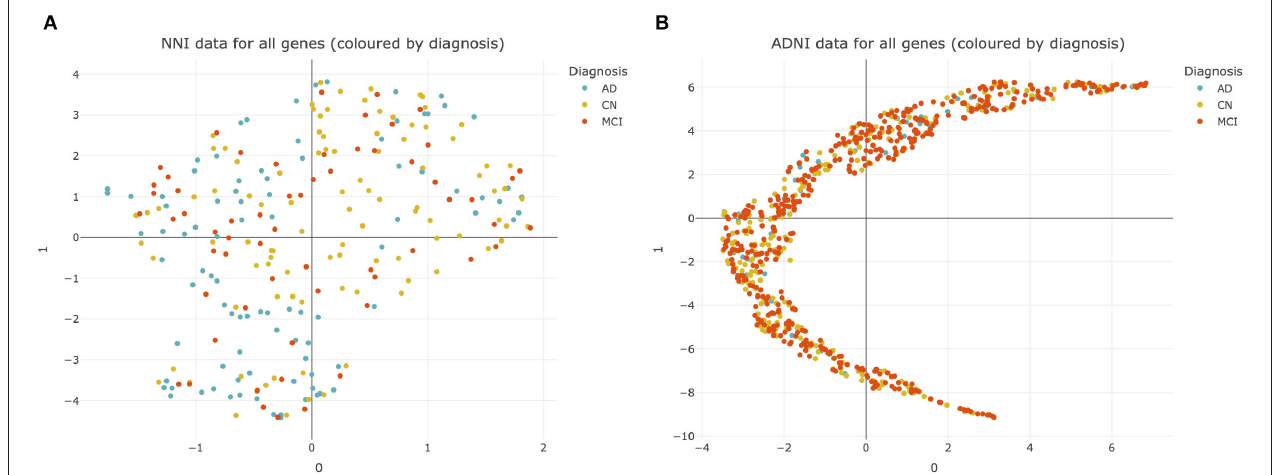
FIGURE 2 | Uniform manifold approximation and projection (UMAP) plots of datasets used for analysis. (A) National Neuroscience Institute (NNI) data colored by diagnosis. Each point represents data from 176 genes from a single subject. (B) Alzheimer’s Disease Neuroimaging Initiative (ADNI) data colored by diagnosis. Each point represents data from 20092 genes from a single subject. CN, cognitively normal; MCI, mild cognitive impairment; AD, Alzheimer’s Disease.